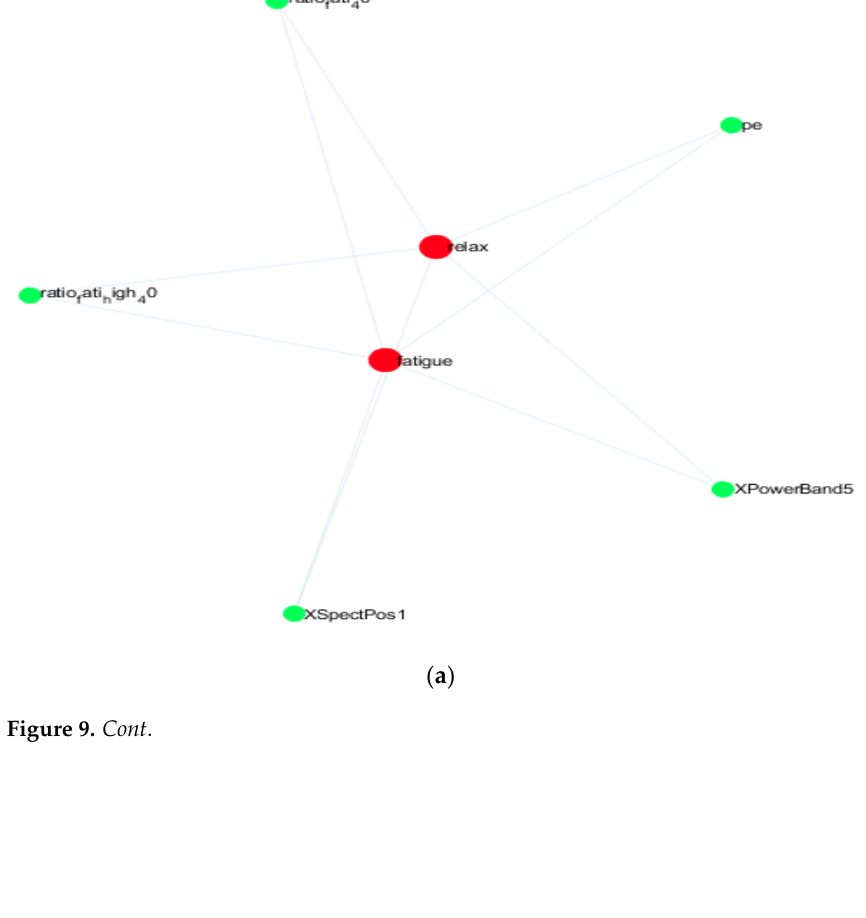
Figure 8. ( a ) The extracted features as a directed graphical. ( b ) Correlation ranking of all features.